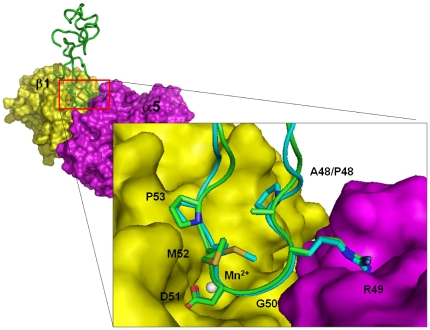
Docking models of Rho and its P48A mutant with integrin α5β1.Representation of Rho (cyan) and its P48A mutant (green) docked on the surface of modelling α5β1. The propeller domain of the α5 subunit and the βA domain of the β1 subunit are in purple and yellow, respectively. A snapshot of the interaction site is also shown. Side chains of the RGD motif of Rho and its P48A mutant are shown and labelled. Manganese ions at MIDAS are in white.